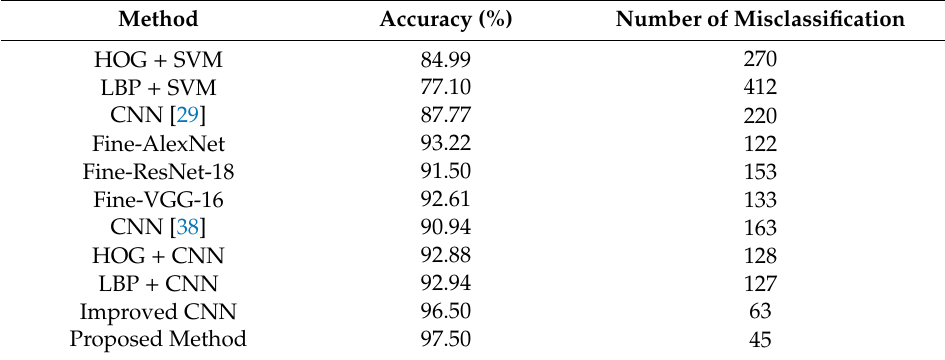
Table 7. Classification accuracy and the number of misclassification samples associated with di ff erent methods when applied to the self-built dataset.